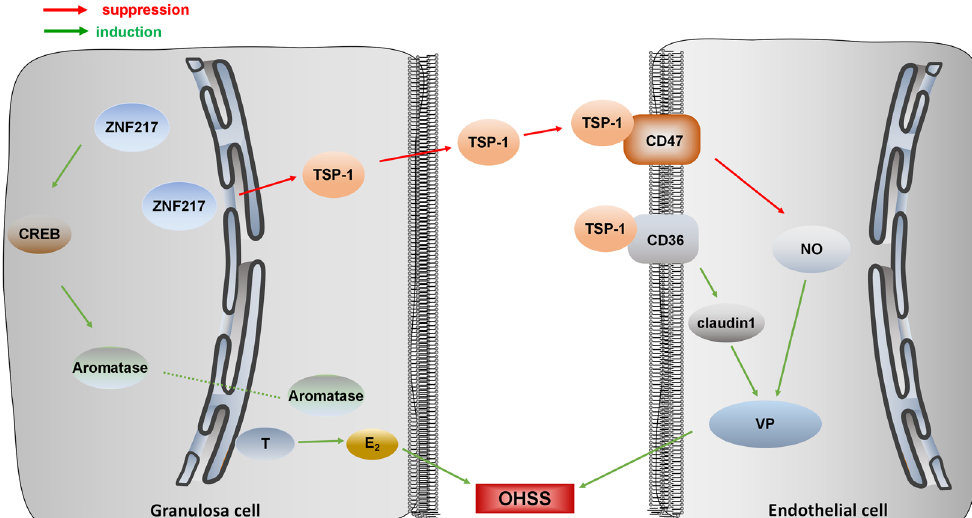
Figure 6. The proposed working model illustrates the mechanism underlying the promotion of ZNF217 to OHSS onset. High expression of ZNF217 in human granulosa cells promoted the transcription of CREB1 and thereby regulating aromatase. Then high E 2 was secreted into serum and participated in the pathogenesis of OHSS. ZNF217 in granulosa cells also inhibited the expression of TSP-1 , resulting in a low TSP-1 concentration in the follicular fluid. The decreased TSP-1 was secreted to follicular fluid and peripheral circulation to enhance NO synthesis and suppress claudin1, leading to a high VP in endothelial cells. Therefore, ZNF217 triggers OHSS onset by promoting E 2 synthesis and inhibiting TSP-1. Green lines indicate promotion function while red lines suggest